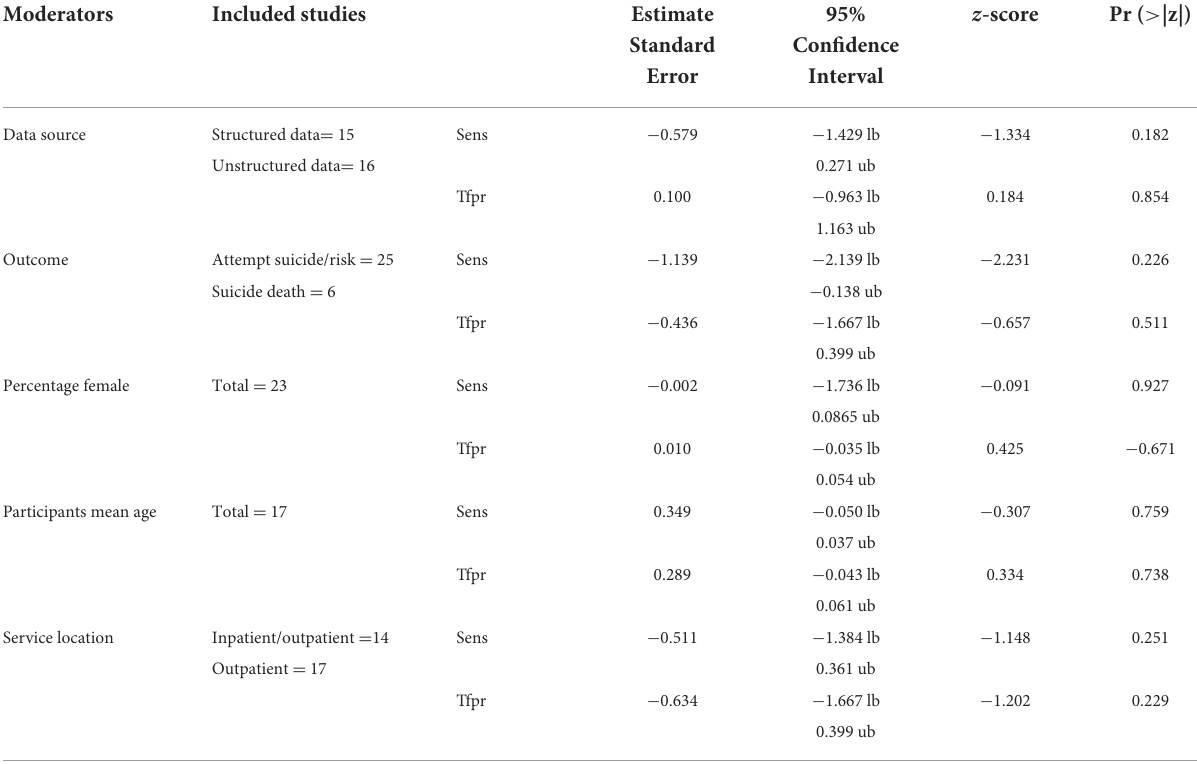
TABLE 3 Bivariate meta-regression